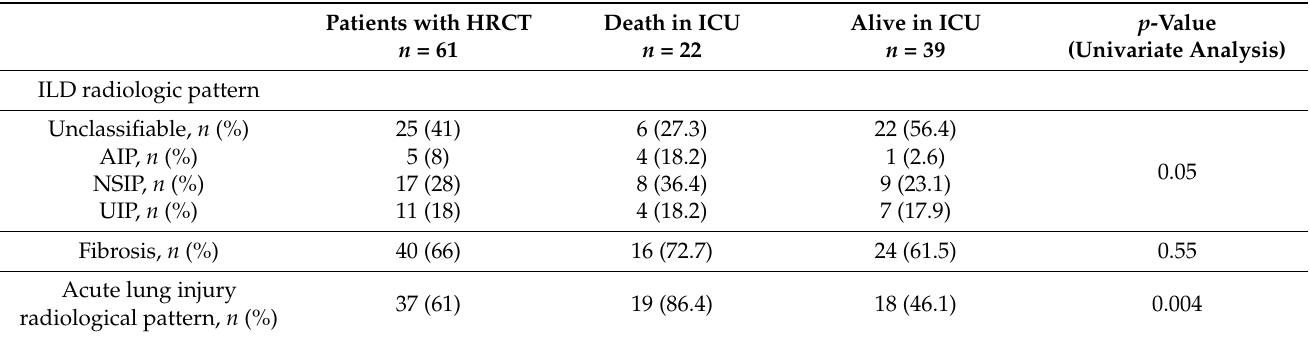
Table 2. Radiological features.